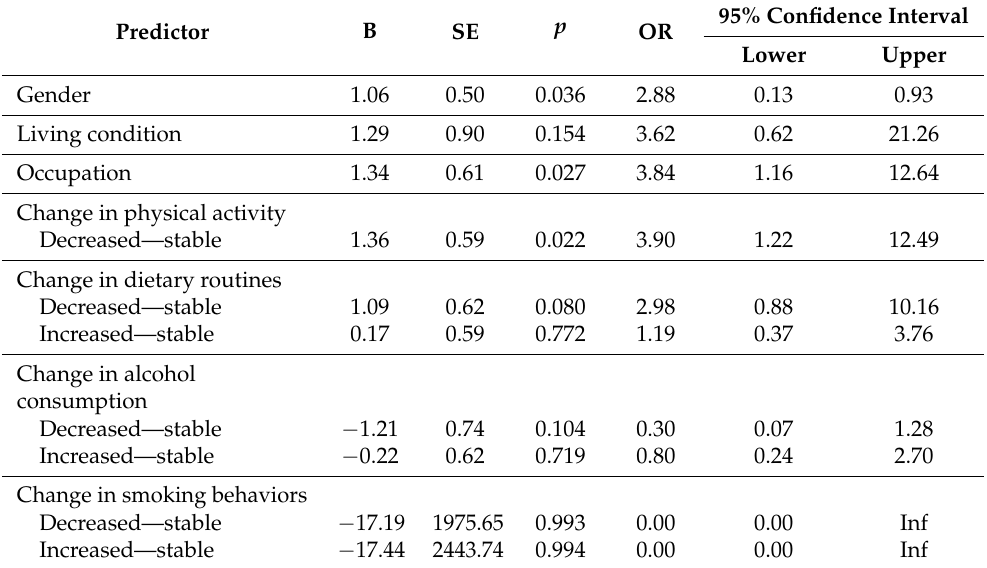
Table 1. Results of the binomial logistic regression